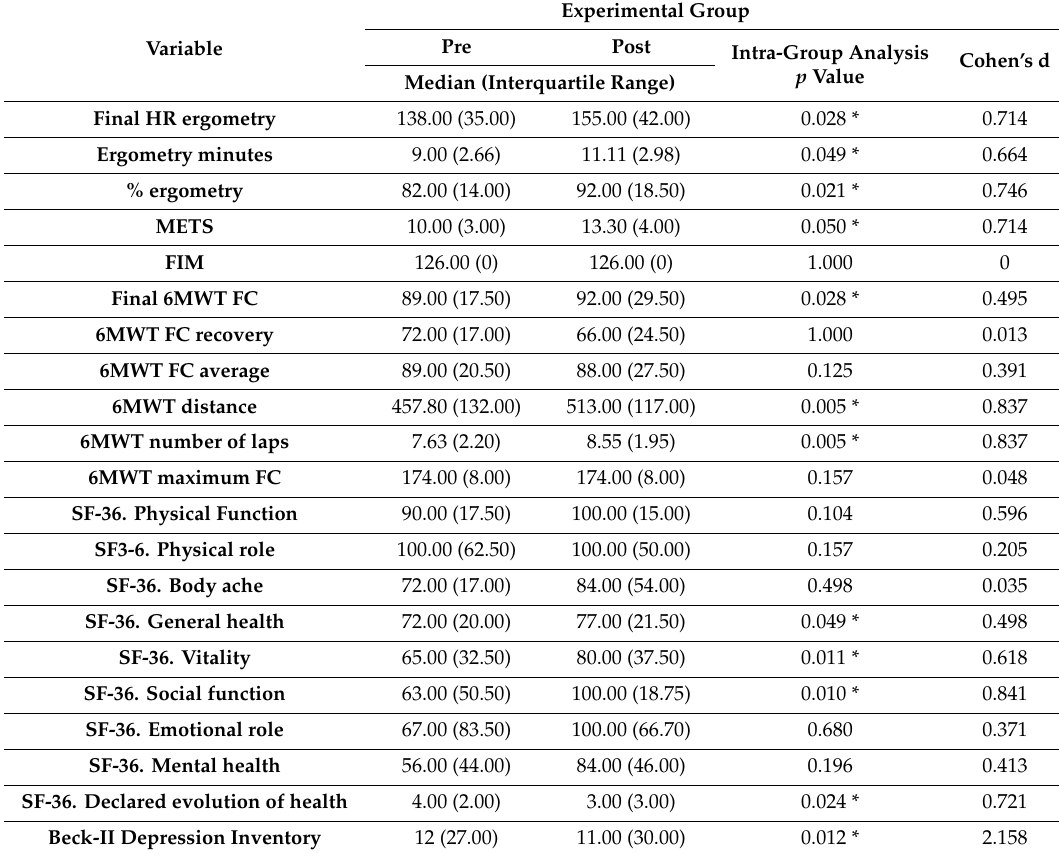
Table 2. Comparison outcome measures experimental group (intra-group